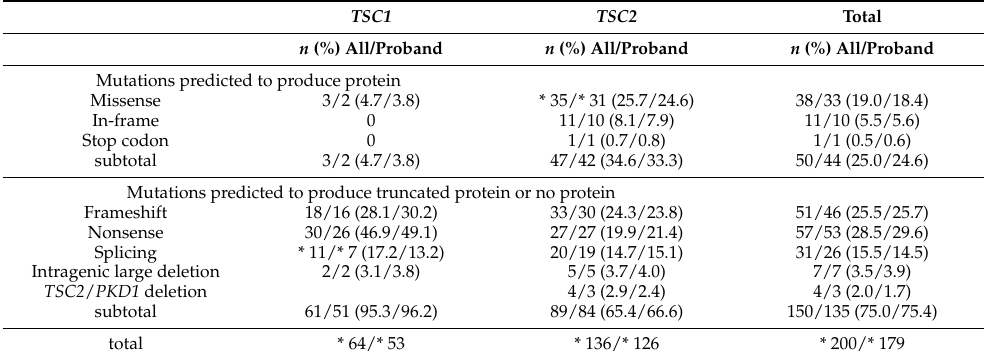
Table 4. Distribution of mutation